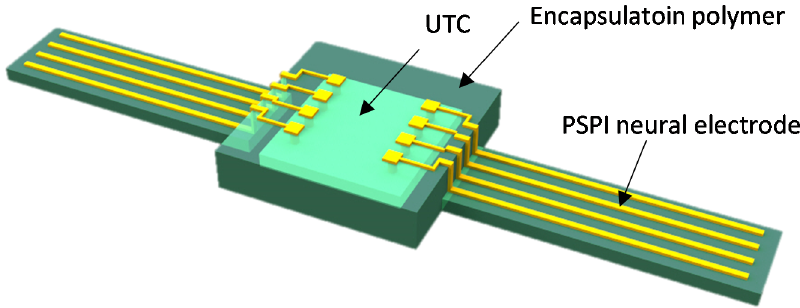
Figure 3. Conceptual drawing of chip-scale biocompatible package.